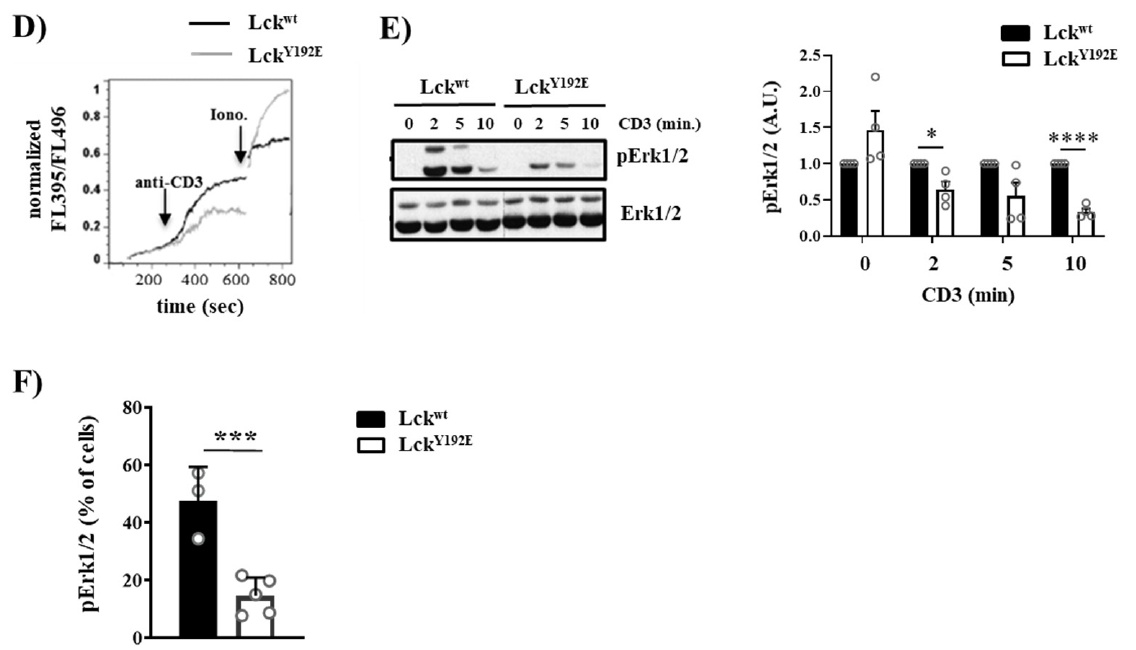
Figure 7. Intact proximal TCR signaling but impaired activation of downstream pathways in stimulated thymocytes from Lck Y192E knock-in mice. ( A , B ) Thymocytes from Lck wt and Lck Y192E mice were stimulated with CD3 antibodies for the indicated time points. Subsequently, cell lysates were prepared, and immunoblot analyses were performed using the indicated antibodies. β -actin was used to show equal loading. One representative immunoblot is shown on the left side of the figure ( n = 3–5). Graphs depicted on the right side in ( A , B ) show statistical analyses of the immunoblots. Bands of the immunoblots were quantified using the Image Studio software, and values were normalized to total Lck signal ( A ) or β -actin signal ( B ). Values of the Lck Y192E mice were further normalized to those of Lck wt mice, which were set to 1 for each time point. ( C ) Representative histogram overlays showing the expression of CD3 and TCR β on thymocytes from Lck wt and Lck Y192E mice ( n = 4). Graphs on the right side depict statistical analyses of the expression of CD3 and TCR β . Mean fluorescence intensity (MFI) of CD3 and TCR β expression from Lck Y192E thymocytes were normalized to MFI values of wild-type cells, which were set to 1. ( D ) Ca 2+ influx was assessed by flow cytometry upon CD3 stimulation of thymocytes from Lck wt and Lck Y192E mice. Ionomycin was used to show equal loading with Indo-1. One representative experiment is shown ( n = 6). ( E ) Thymocytes from Lck wt and Lck Y192E mice were stimulated with CD3 antibodies for the indicated time points. Subsequently, cell lysates were prepared, and the activation of Erk1/2 was assessed by immunoblotting using a phospho-specific Erk1/2 antibody. Total Erk1/2 was used to show equal loading. One representative immunoblot from four experiments is shown. The graph on the right side shows quantification of the pErk1/2 signal calculated as described above ( A , B ). ( F ) Bar graph represents summary statistics of the activation of Erk1/2 in transitional stage thymocytes determined by intracellular flow cytometry ( n = 3–5). In all graphs depicted in this figure, each dot represents one mouse, whereas columns show mean values of all analyzed mice + SEM. Statistical analyses were performed using an unpaired Student’s t test (* p ≤ 0.05, ** p ≤ 0.01, *** p ≤ 0.001, **** p ≤ 0.0001; where not indicated, the values were not statistically significant).